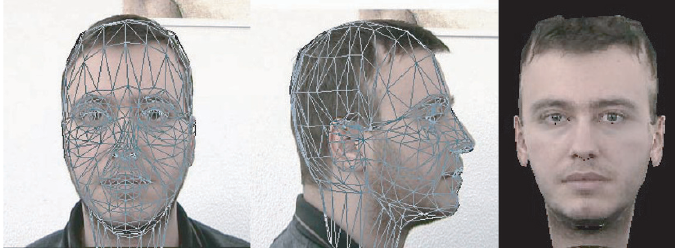
Figure 17: FPD adaptation on Nikolas test image.